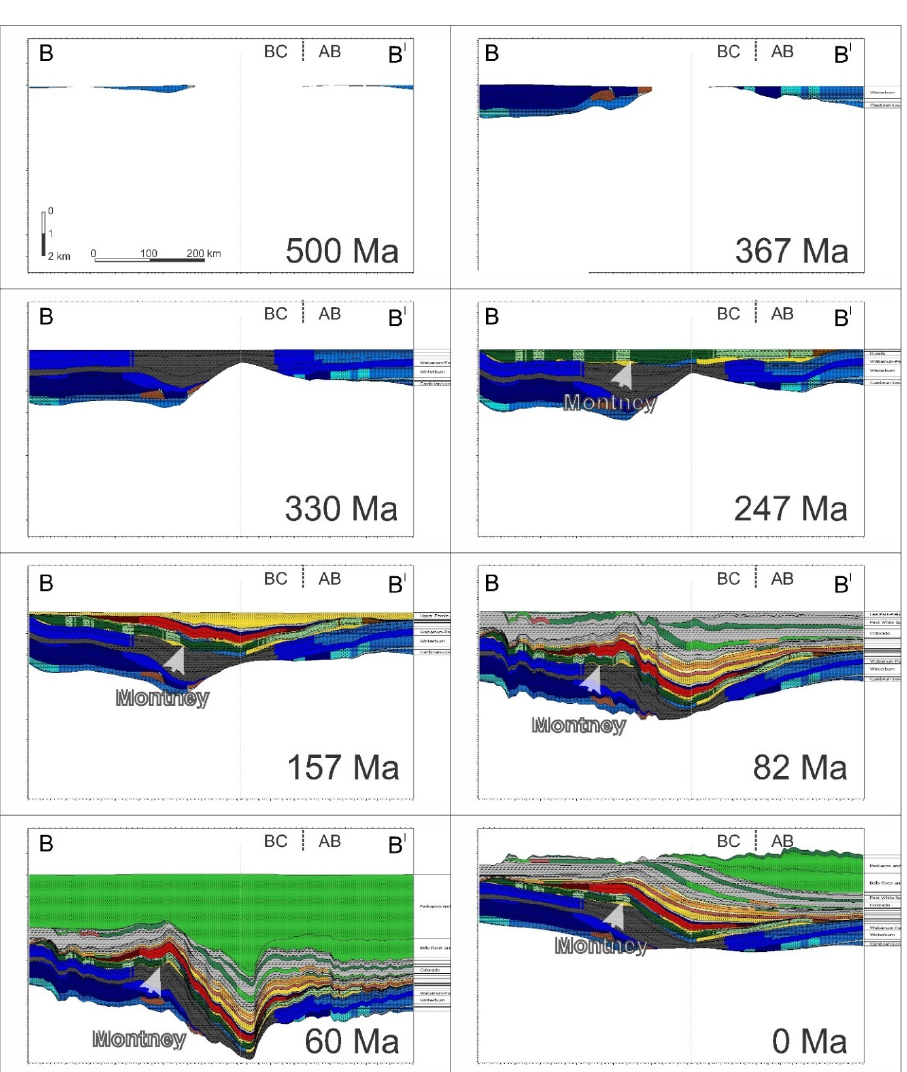
Figure 16. Legend for facies used in the basin model and shown in cross-sections A–A ′ and B–B ′ (Figures 15 and 17, respectively).